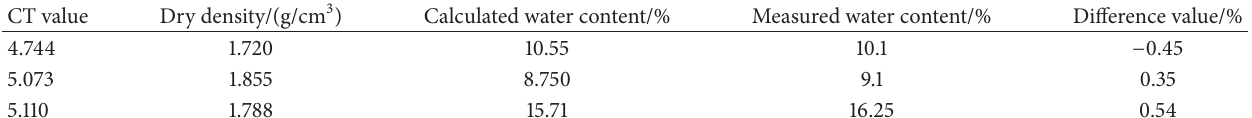
Table 1: Validation of the relationship between water content, dry density, and CT value.